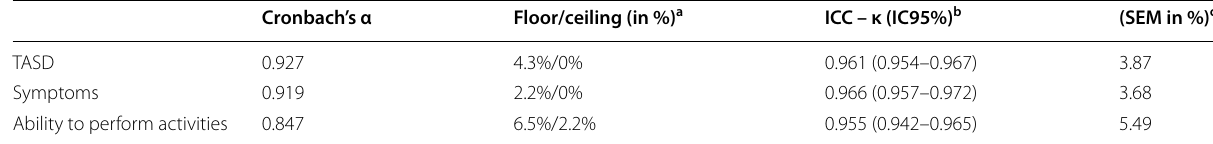
a Percentage of scores less than 5 or greater than 95 b ICC—Intraclass Correlation Coefficient c SEM—Standard Error of